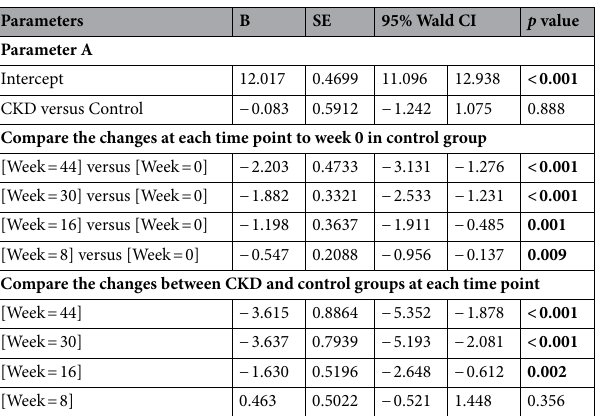
Parameters B SE 95% Wald CI p value Parameter